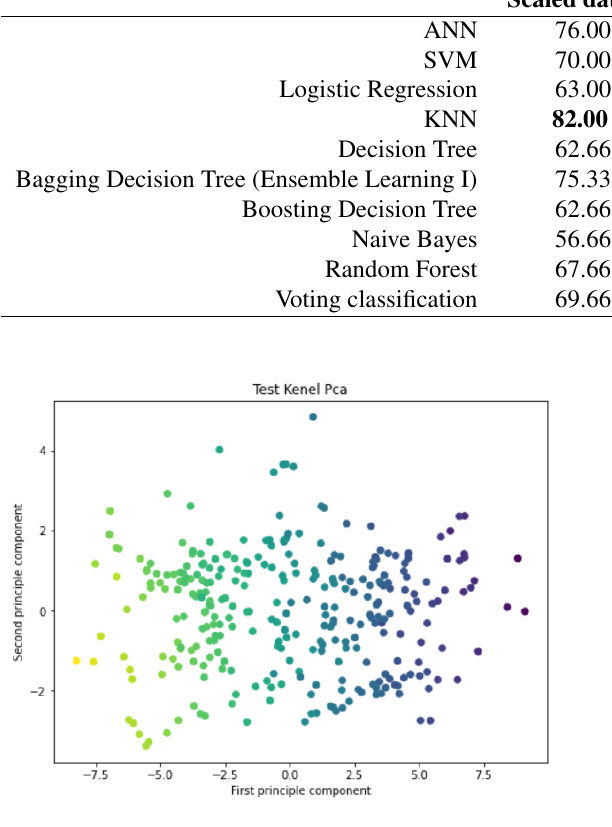
level co-occurrence matrix feature extraction